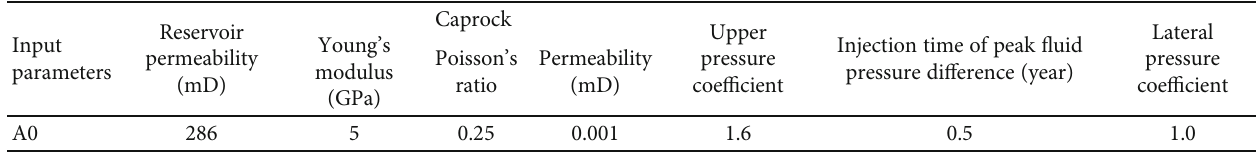
Table 2: Basic scenario of A0.